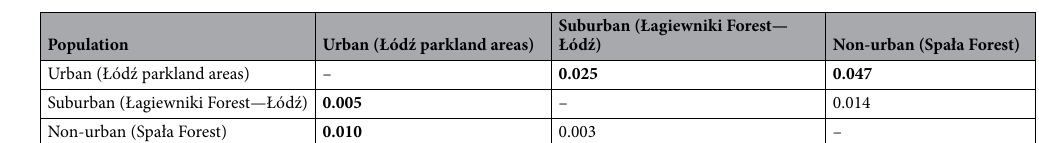
Table 4. Matrix of pairwise F ST (below diagonal) and F ′ ST (above diagonal) estimates for ten microsatellite loci between studied populations of the great tits. Bold entries highlight significant values. Urban, suburban and non-urban populations are represented by individuals sampled in Łódź parkland areas, Łagiewniki Forest, and Spała Forest, respectively.